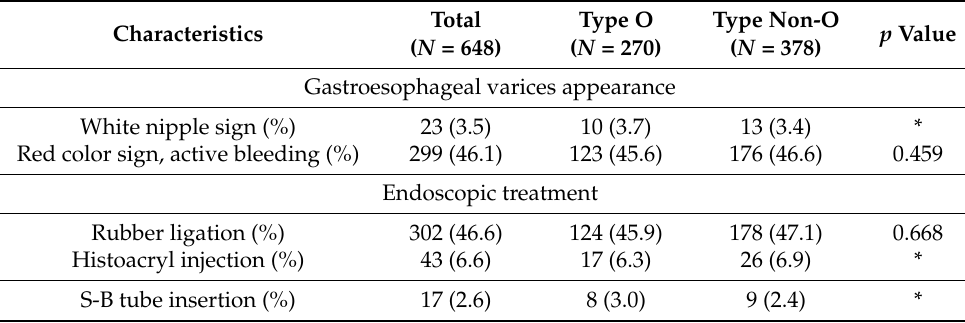
Table 3. Endoscopic findings and treatment.